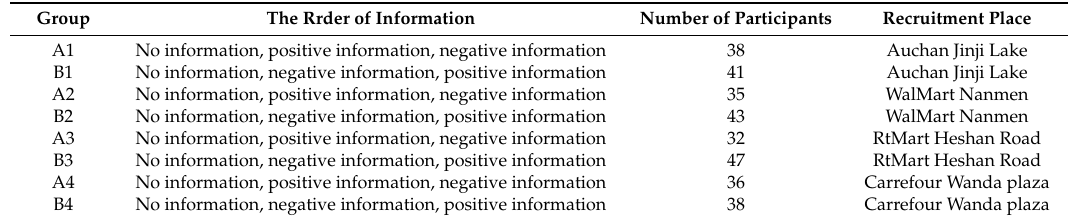
Table 1. The recruitment plans and information release order.